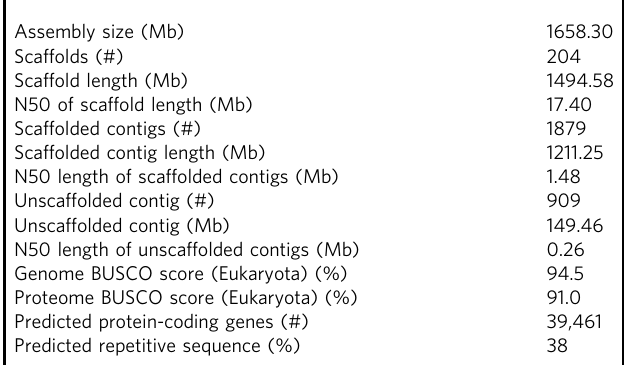
Table 1 Isoetes taiwanensis genome assembly